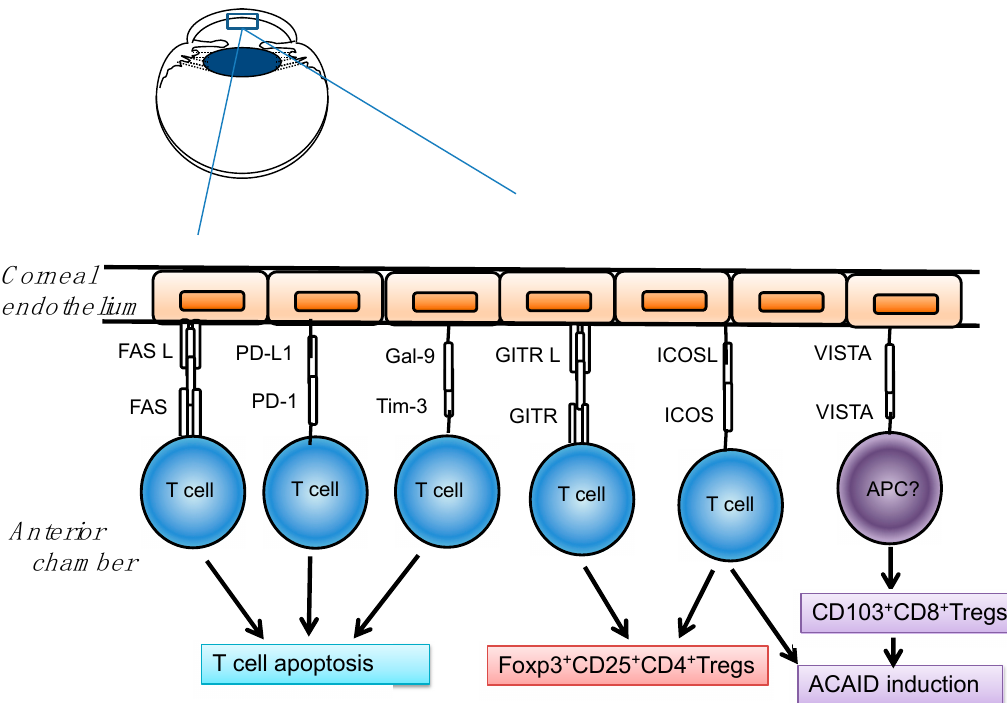
Figure 1. Constitutive expression of immune checkpoints in endothelial cells of the cornea. Programmed death (PD)-L1 induces apoptosis of PD-1+ T cells. Fas Ligand (FasL) induces T-cell apoptosis via Fas. Galectin-9 (Gal-9) also induces apoptosis of T cells and protects corneal endothelium. Glucocorticoid-induced tumor necrosis factor receptor family-related protein (GITR)- ligand